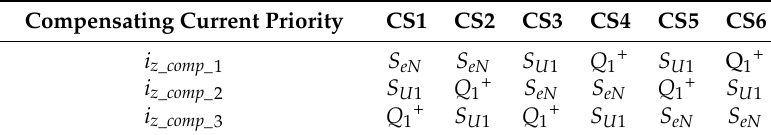
Table 1. SAPC power compensation